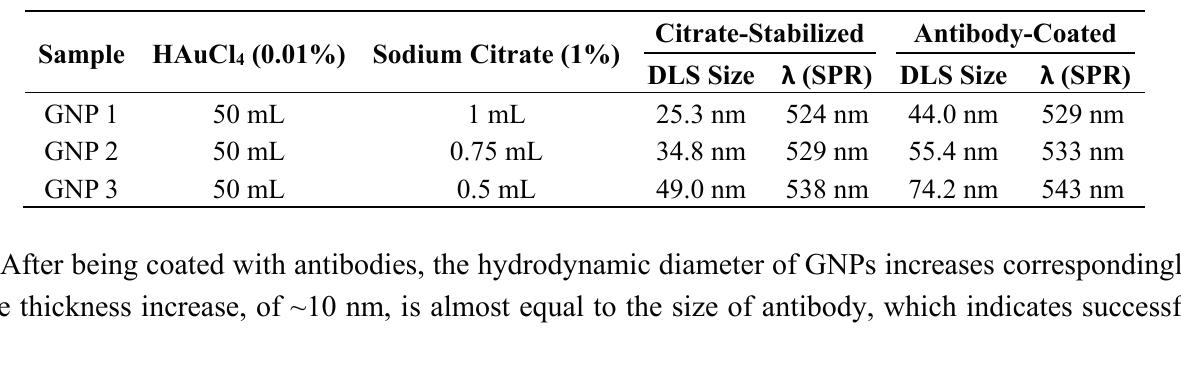
Table 1. The preparation and physical properties of